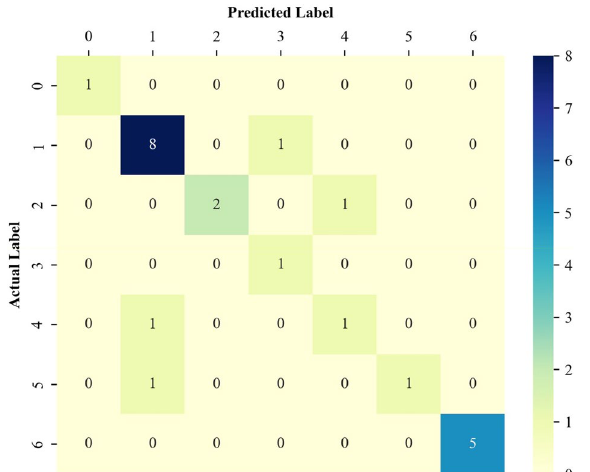
Figure 7. The confusion matrix of the designed model related to the testing data